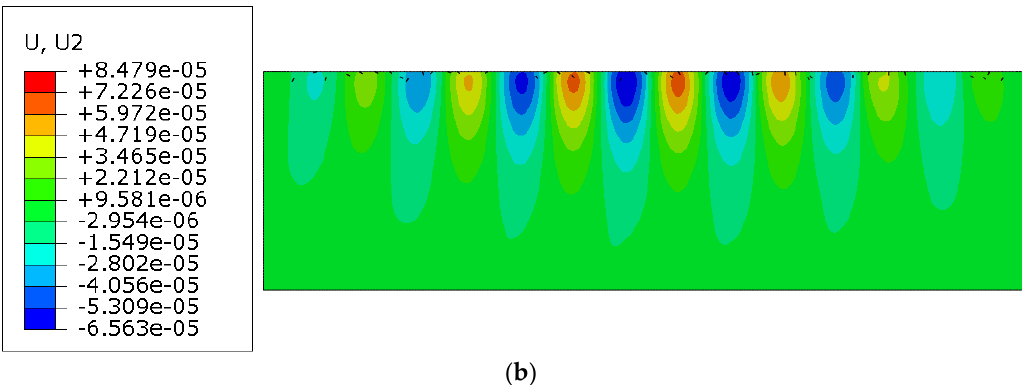
Figure 4. Propagation of surface waves in a structure with surface micro-cracks ( c = 0.1, f = 1000 kHz, µ = 0.1, w % = 60%). ( a ) Displacement contour in the x direction (800 times zoomed deformed shapes in the dashed box); ( b ) Displacement contour in the y direction.